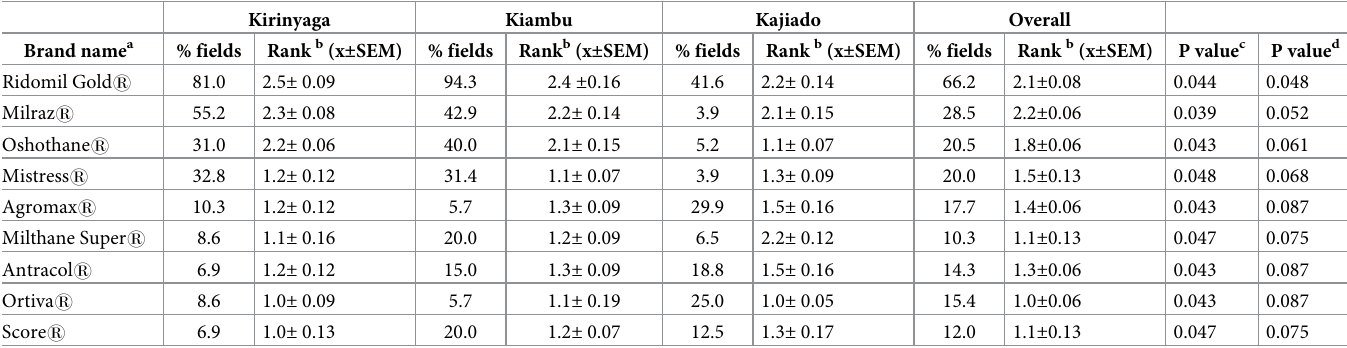
Table 5. Fungicide products used to control tomato early blight in three surveyed counties of Kenya, January-March